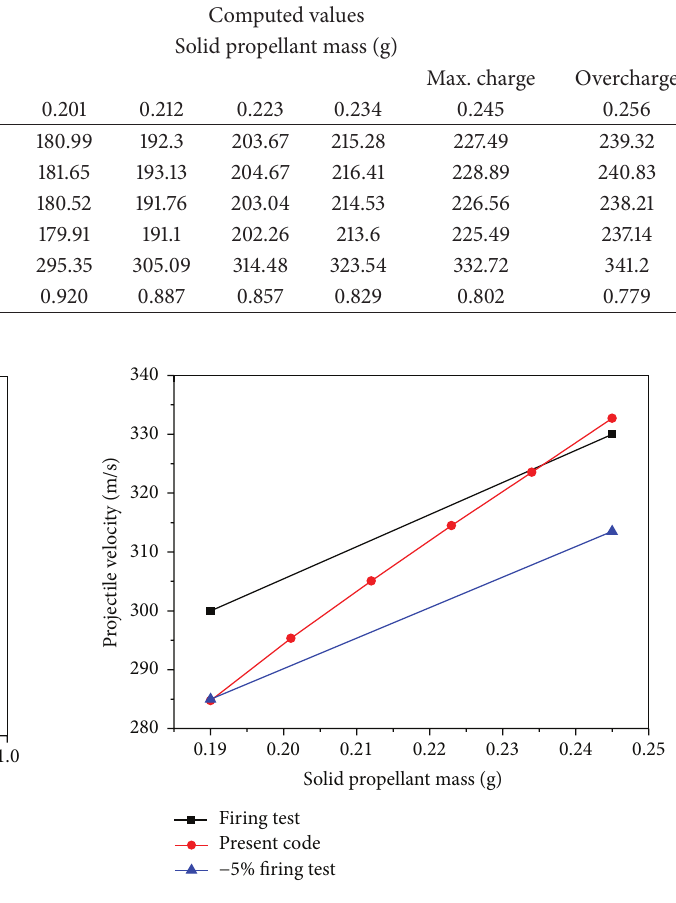
Figure 14: Muzzle velocity against propellant weight